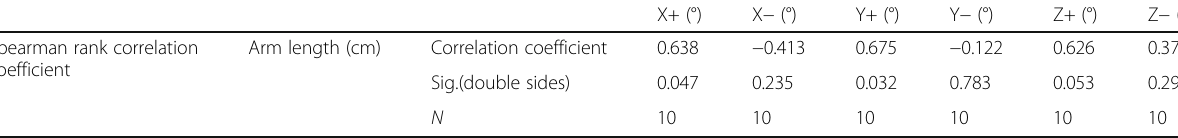
Table 6 Operation space range and arm length correlation coefficient